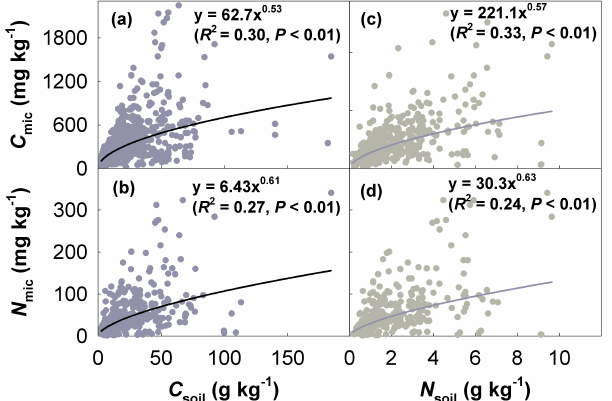
Figure 3. Relationships between soil resources and microbial biomass. C soil , N soil , C mic , and N mic stand for soil organic car- bon, soil total nitrogen, microbial biomass carbon, and microbial biomass nitrogen, respectively. The regression models are given.